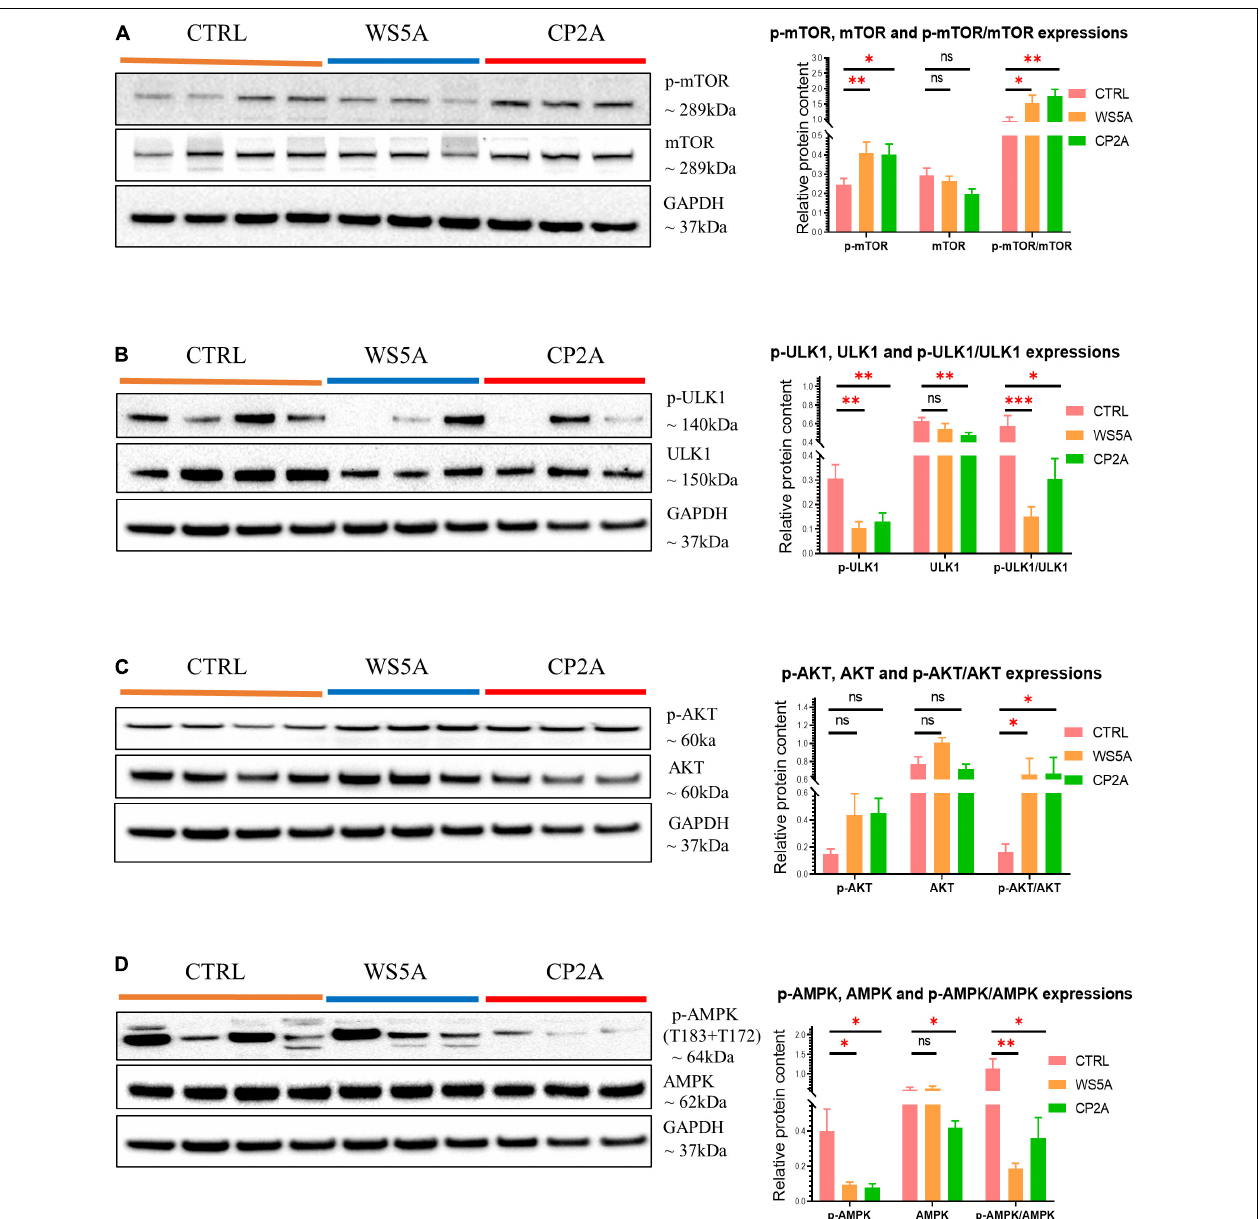
FIGURE 5 | POLG-mutant astrocytes demonstrate mitophagy impairment via modulating AKT/mTOR/AMPK/ULK1 signaling axis. (A) Representative images of western blotting for p-mTOR, mTOR, GAPDH, and quantitative measurements of protein levels in WS5A, CP2A, and control astrocytes. (B) Representative images of western blotting for p-ULK1, ULK1, GAPDH, and quantitative measurements of protein levels in WS5A, CP2A, and control astrocytes. (C) Representative images of western blotting for p-AKT, AKT, GAPDH, and quantitative measurements of protein levels of in WS5A, CP2A, and control astrocytes. (D) Representative images of western blotting for p-AMPK (T183 + T172), AMPK, GAPDH, and quantitative measurements of protein levels in WS5A, CP2A, and control astrocytes. Data information: the loading controls from D are re-used from B,C . The data in A–D represent four different control astrocytes, including three clones from Detroit 551 control and one clone from AG05836 control, three clones from WS5A and three clones from CP2A. Data are presented as mean ± SEM for the number of samples ( n ≥ 3 per clone). Mann–Whitney U test was used for the data presented in A–D . Significance is denoted for p -values of less than 0.05. * p < 0.05; ** p < 0.01; *** p < 0.001; ns, not